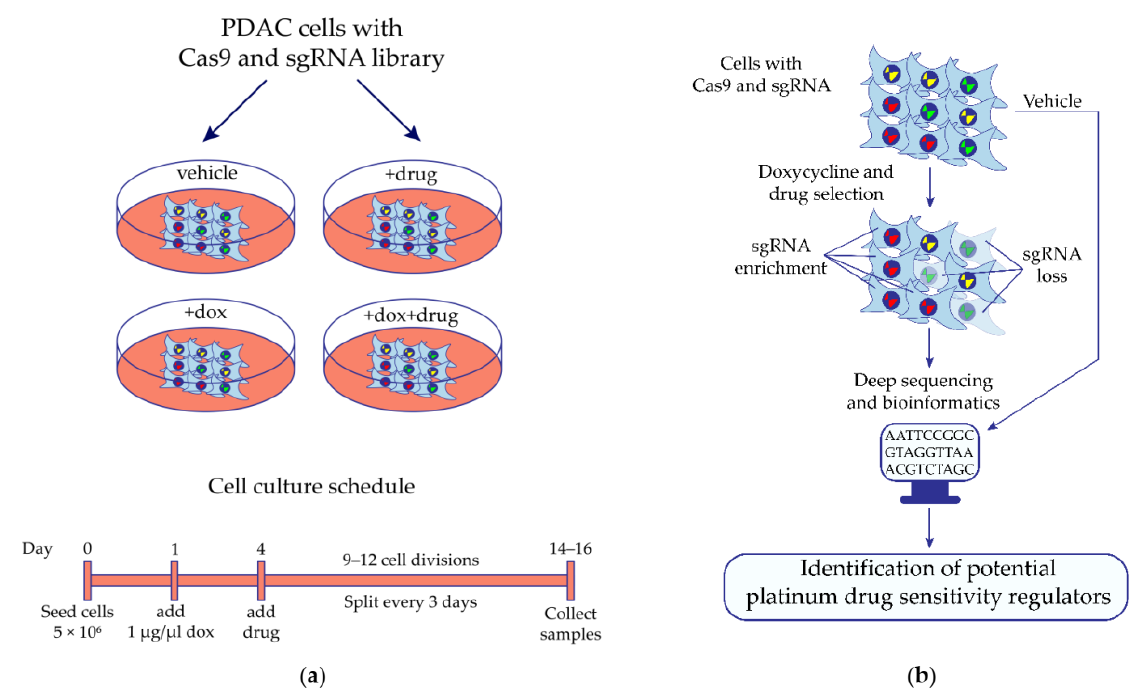
Figure 1. Identification of potential regulators of MIA PaCa-2 pancreatic cancer cell sensitivity to platinum drugs by the synthetic lethal knockout CRISPR/Cas9 screening. ( a ) The design of the synthetic lethal knockout CRISPR/Cas9 screening of pancreatic ductal adenocarcinoma (PDAC) cell line MIA PaCa-2. ( b ) Application of the high-throughput synthetic lethal knockout CRISPR/Cas9 screening to identify potential predictive biomarkers. Cells expressing doxycycline-inducible Cas9 and transduced with the lentiviral sgRNA library are cultivated in the presence or absence of the studied drug. If Cas9-mediated knockout of the gene leads cells to death in the presence of the drug, then representation of the corresponding sgRNA has decreased in the cell population, and vice versa compared with the control conditions. Differently presented sgRNA are identified by deep sequencing of the sgRNA-containing region of cell genomic DNA integrated during lentiviral transduction of cells with the sgRNA library. Bioinformatics and statistical approaches are used to find gene knockout which significantly changed the sensitivity of cells to the studied drug.